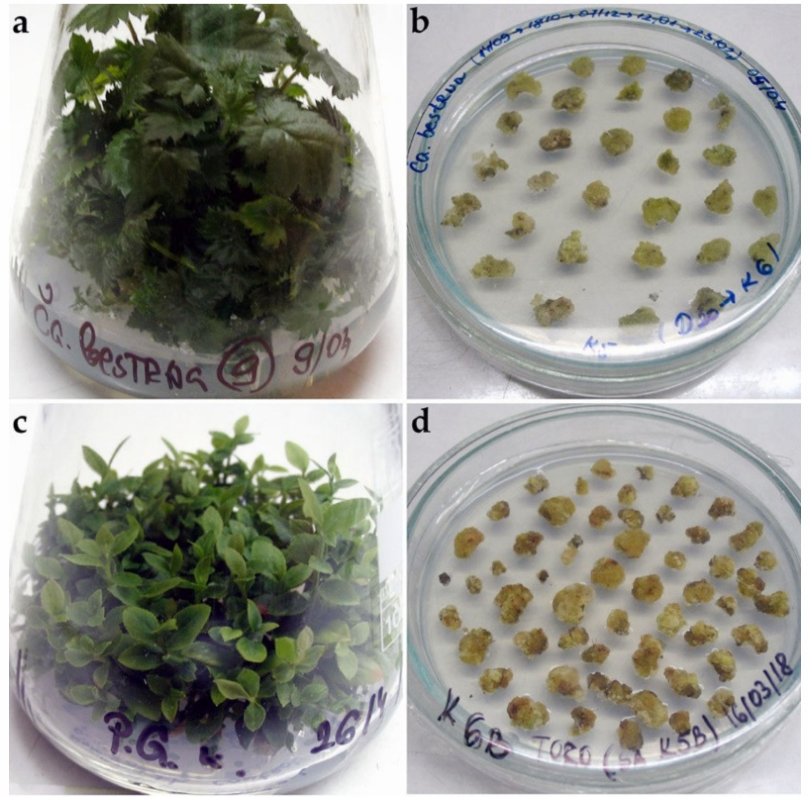
Figure 1. In vitro shoot and callus cultures of blackberry ‘ ˇCaˇcanska Bestrna’ ( a , b ) and blueberry ‘Toro’ ( c , d